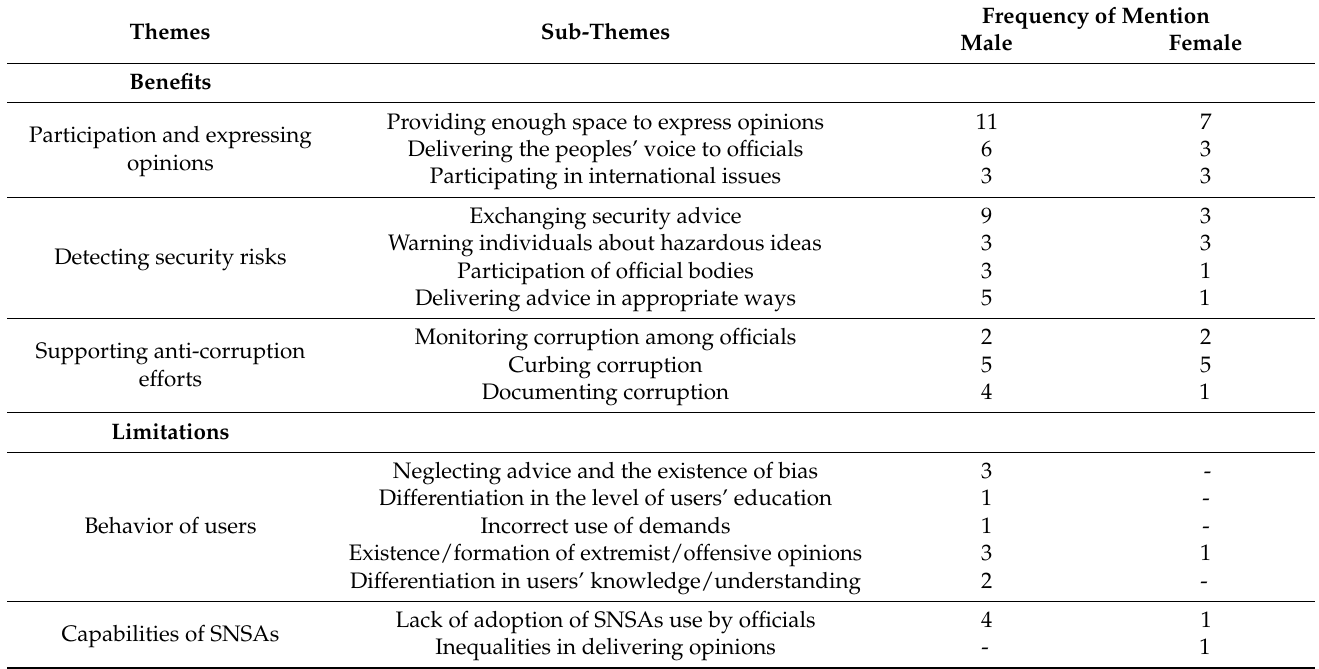
Table 11. Themes relating to SNSAs and political